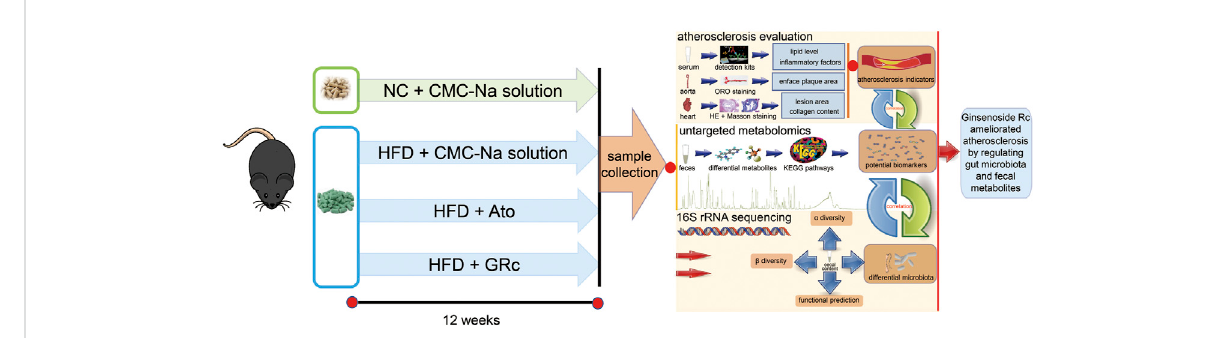
FIGURE 1 Work fl ow for examining the anti-atherosclerotic effects and potential mechanisms of GRc against AS in ApoE − / − mice. Differential gut microbiota, fecal metabolites, and AS indexes were conjointly analyzed in the